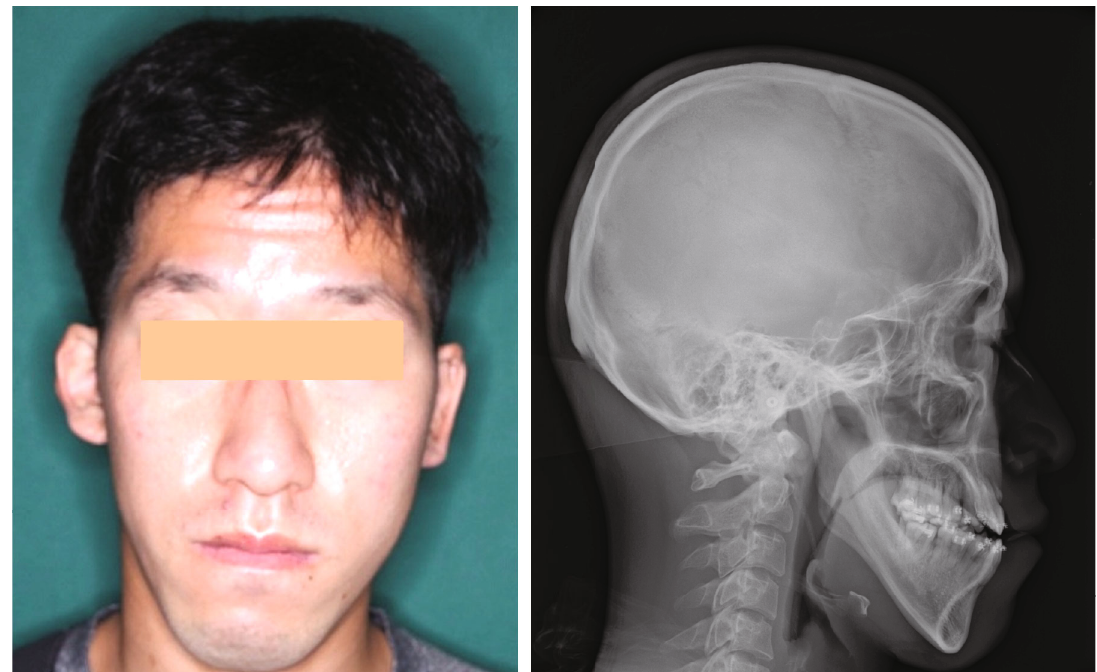
Figure 1: Preoperative facial photograph and lateral cephalometric radiograph. The mandible is deviated to the right, with anterior